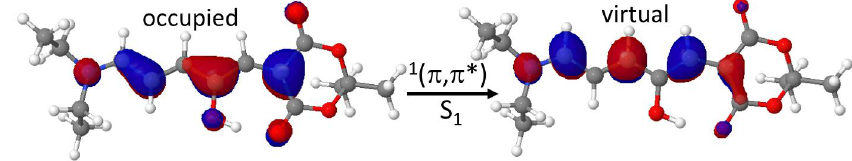
Table 2. Vertical excitation energies ( E S0 → S1 ) for different solvents. All simulated values are calculated by the polarizable continuum model (PCM). All values are given in eV (nm).